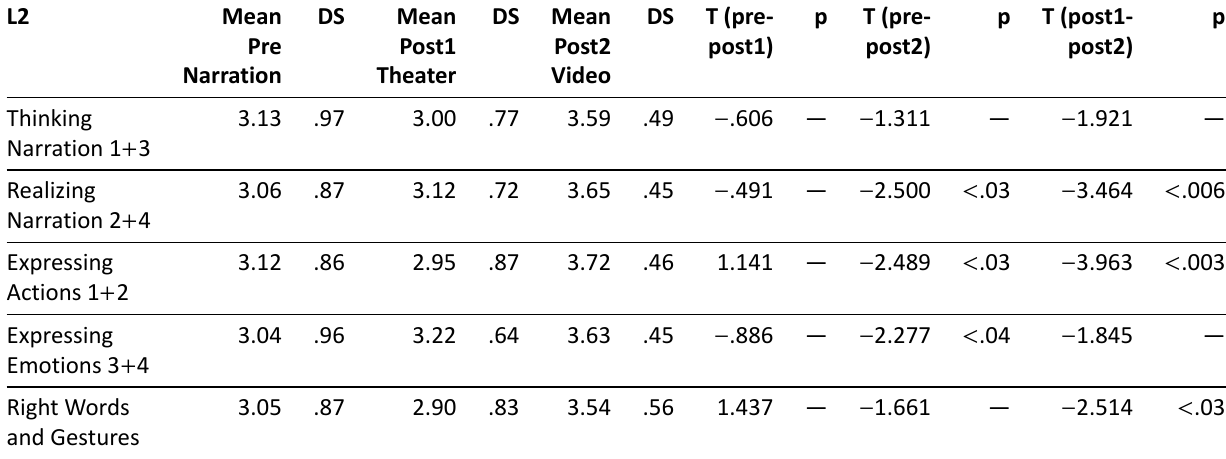
Table 3. Pre-test, post-test 1 theater and post-test 2 video: means, standard deviations and results of t-test for self-efficacy according to categories for international migrant students